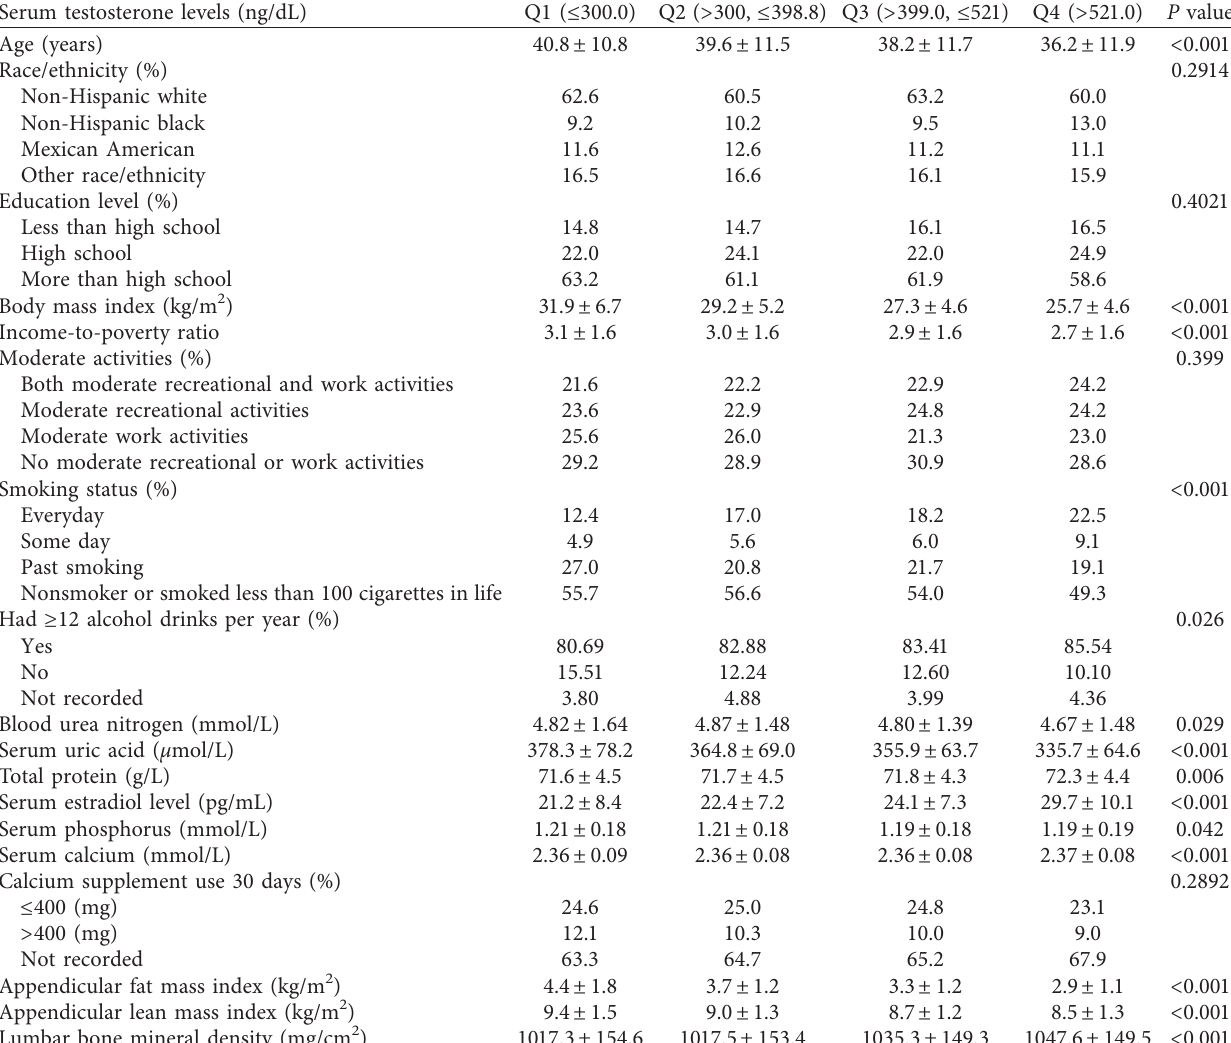
Table 1: Weighted characteristics of study population based on serum testosterone levels quartiles. Serum testosterone levels